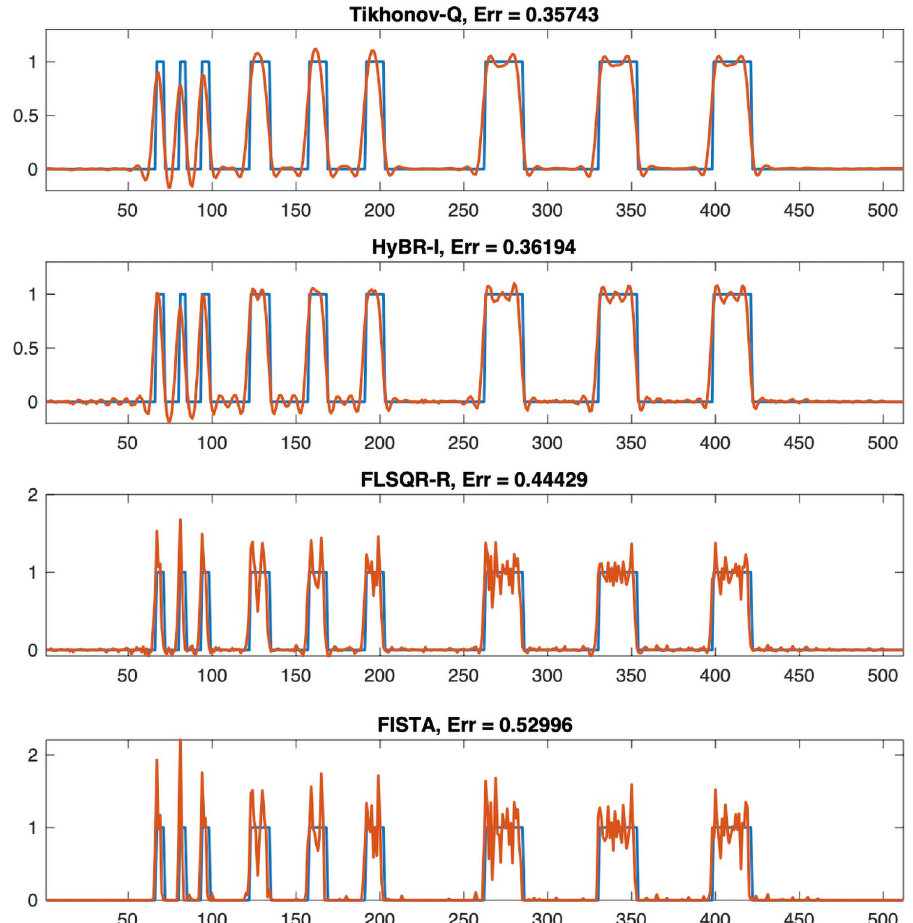
Fig 9. Reconstructed signals ~ x using different regularization techniques. All reconstructions correspond to ~ h in Fig 8.